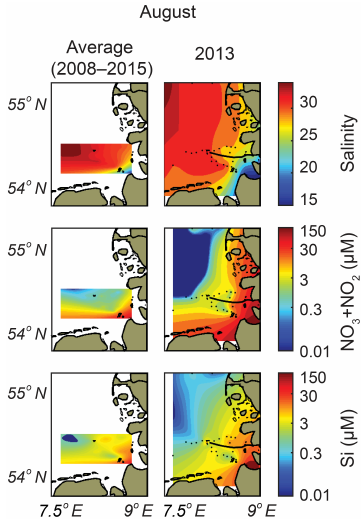
Figure 11. Same description as in Fig. 10, for the month of July. The left panels show average parameter distributions in July, based on 7 years of data (2008–2015, excluding 2013) from BAH AWI stations (Table 1); the right panels show interpolated parameters from 2 to 11 July 2013, measured at BAH AWI, BSH, FerryBox and HPA stations (Tables 1 and 4).